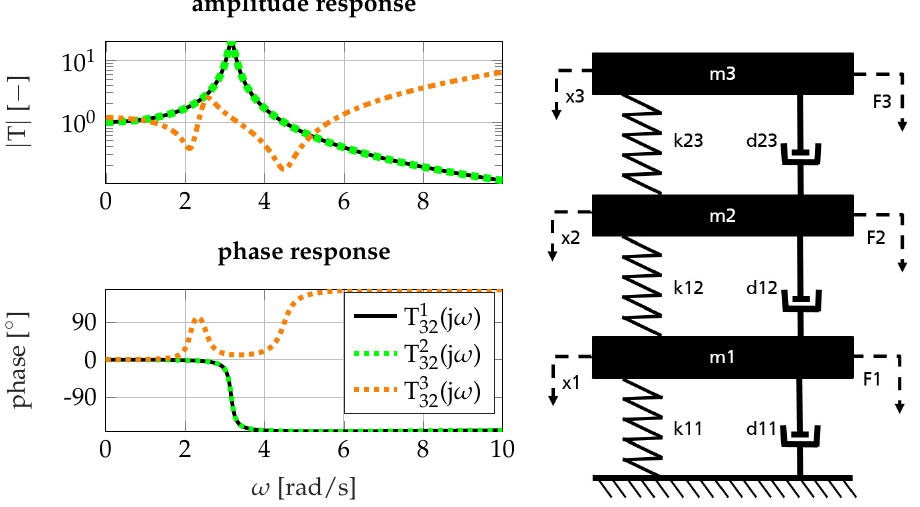
Figure 3. Theory of TMFs shown on a simple dynamic system.